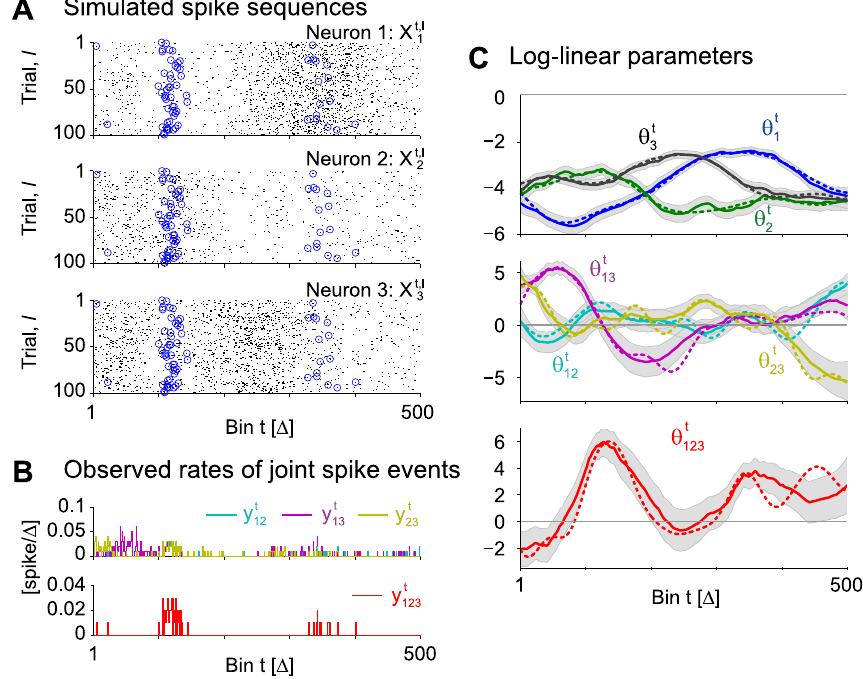
Figure 4. Estimation of triple-wise interaction from simulated parallel spike sequences of 3 neurons. (A) Dot displays of the simulated spike sequences, X t , l , which are sampled repeatedly for n ~ 100 trials from a time-dependent log-linear model containing time varying pairwise and triple-wise interactions (duration: T ~ 500 bins; see the dashed lines in C for the model parameters). Each of the 3 panels shows the spike events for ( t ~ 1, ... , T and l ~ 1, ... , n ), as black dots. Synchronous spike events across the 3 neurons as detected in each of the 3 variables, X t , l , X t , l , X t , l 1 2 3 ( I [ V 2 , V 3 f g ). (Top) Observed rates of the synchronous spike individual trials are marked by blue circles. (B) Observed rates of joint spike events, y t I events between all possible pair constellations as specified by index I ( I [ V 2 ). (Bottom) Observed rate of the synchronous spikes across all 3 neurons, y t . (C) Smoothed estimates of the time-varying log-linear parameters, h t . The three panels depict the smoothed estimates (solid lines) of the log- 123 , of the different orders ( I [ V 1 , V 2 , V 3 f g ), as obtained from the data shown in A and B (top and middle: the first and second order linear parameters, h t I ). The gray bands indicate the 99% credible interval of the marginal posterior log-linear parameters; bottom: triple-wise spike interaction, h t 123 densities of the log-linear parameters. The dashed lines indicate the underlying time-dependent parameters used for the generation of the spike